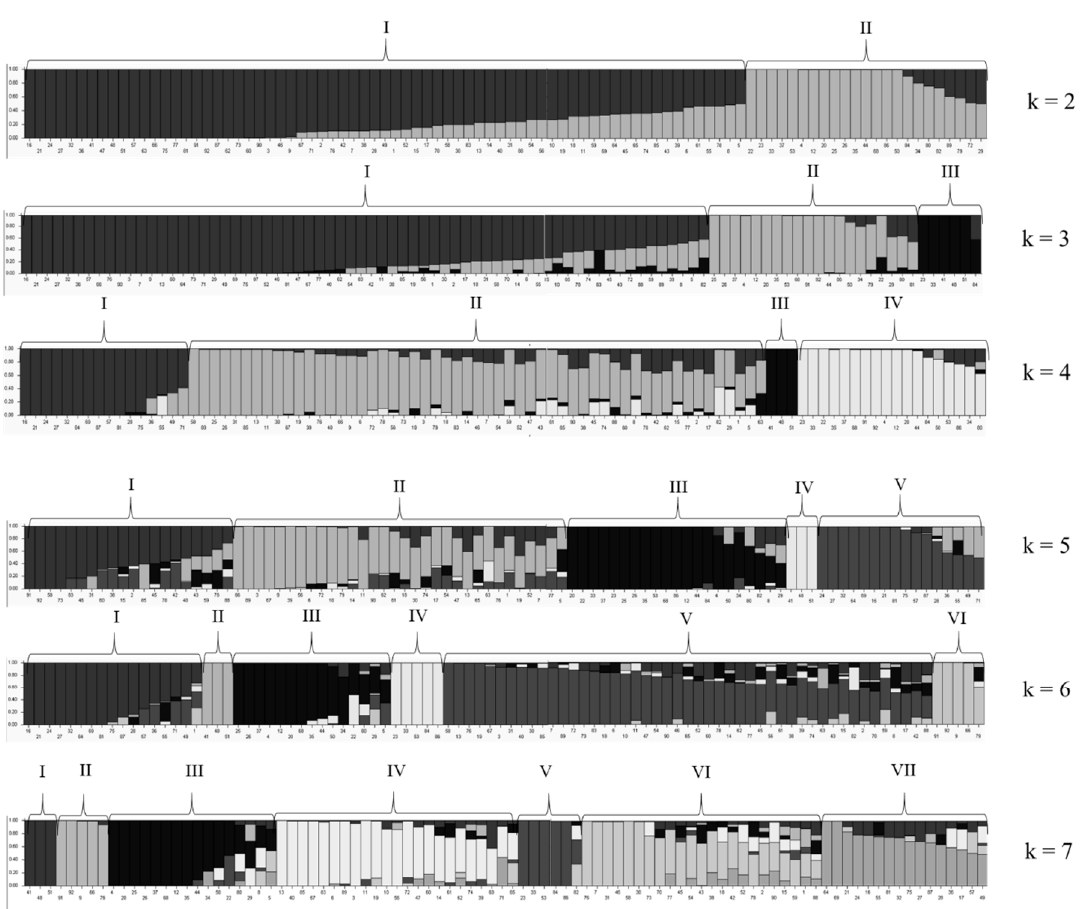
Figure 3. Structure of subpopulations of potato varieties in this study for k from 2 to 7.